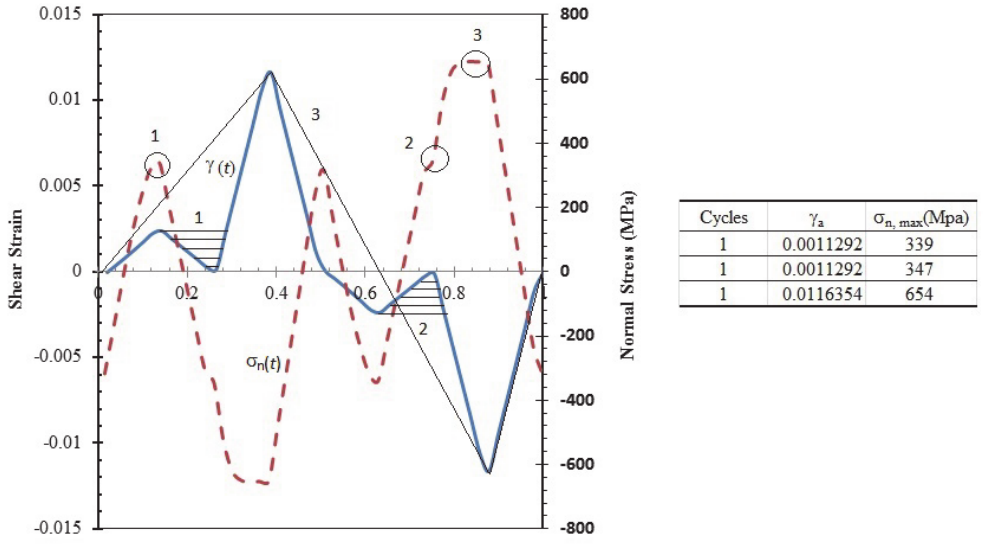
Figure 1: Schematic of BS cycle counting method.